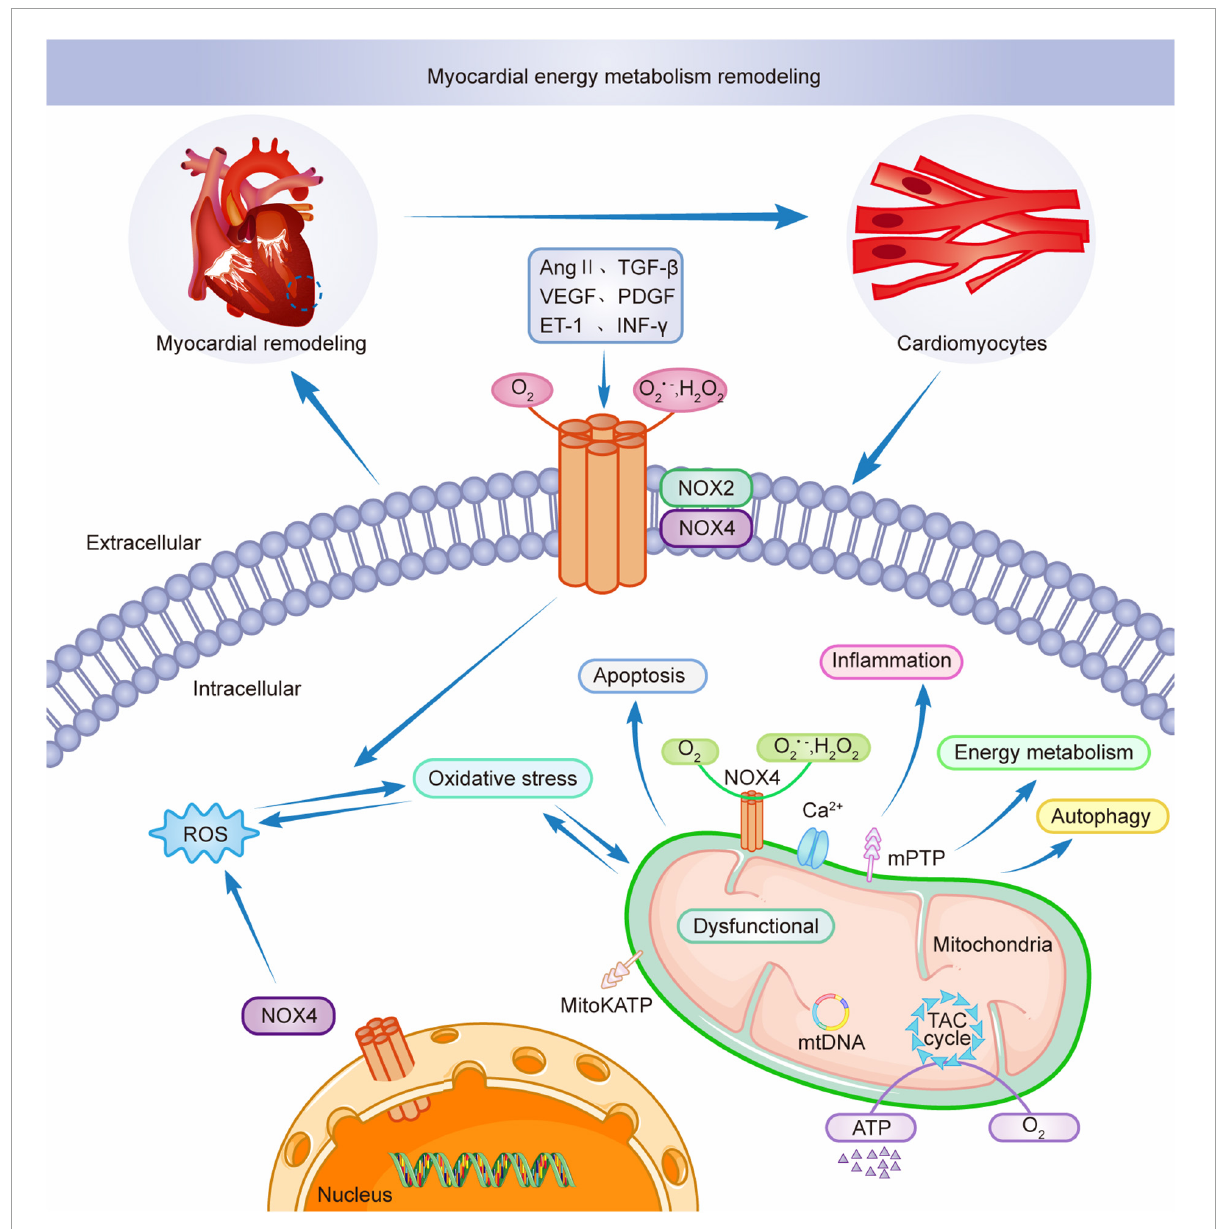
FIGURE3 NOX2 and NOX4 participate in myocardial energy metabolism